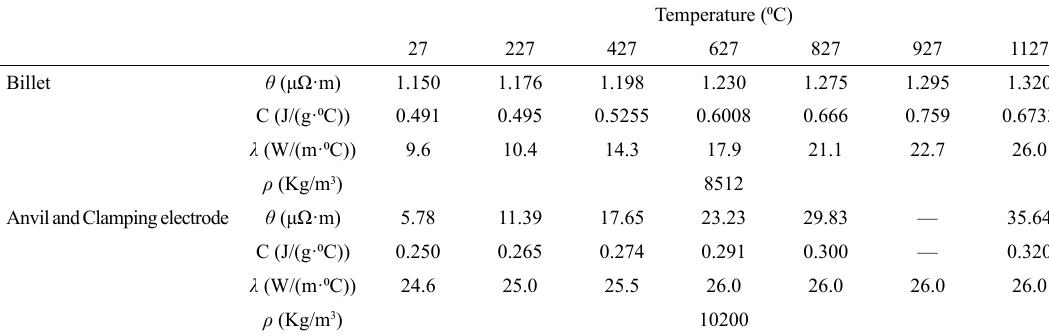
Figure 6: The finite element analytical model of electric upsetting process. Table 1: Physical properties of the